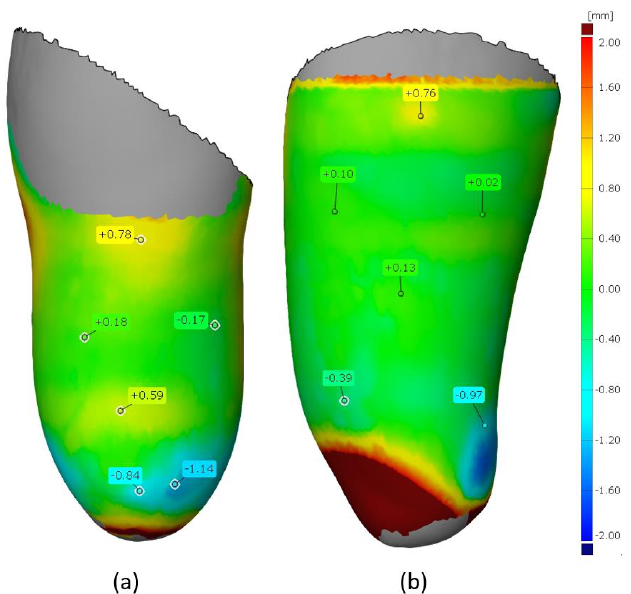
Figure 13. Deviation map for the sockets of PLA. Type: ( a ) VAC and ( b ) VEL.